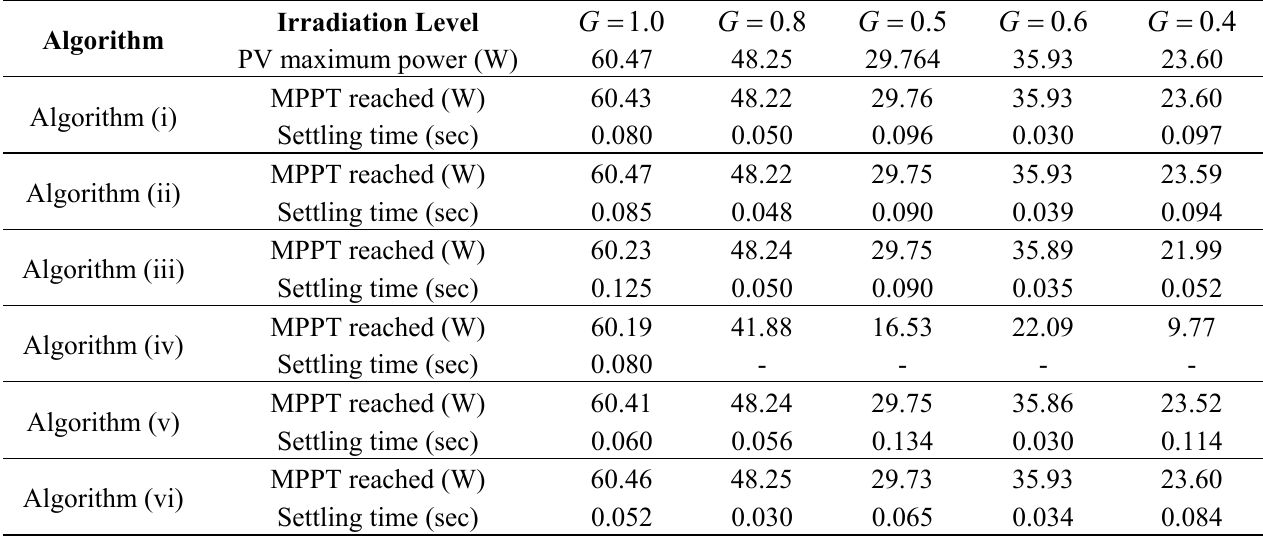
Table 2. Summary of the simulation